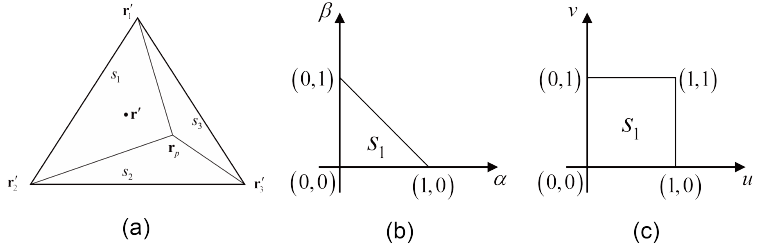
Figure 4. Duffy transformation for triangles, ( a ) coordinates of the integration triangle, ( b ) mapping s 1 to a standard triangle and ( c ) mapping s 1 to a standard